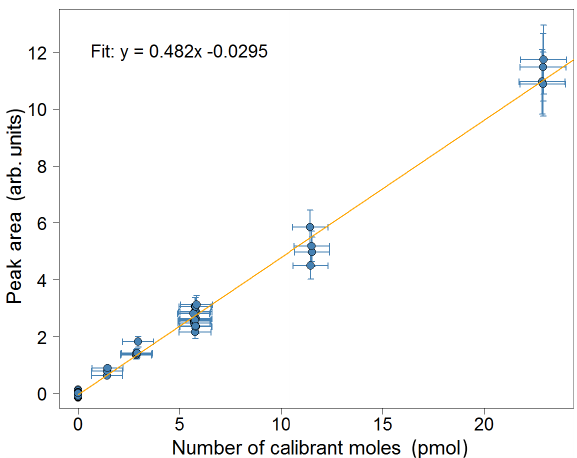
Figure 7. Calibration plot for isoprene for the week of 2– 8 July 2018 from the Wytham Woods field campaign. Error bars in the area correspond to the precision of the measurement ( ± 10 . 4%). Error bars in the calibrant moles are estimated from the uncertain- ties in the secondary standard used and in the volume of gas sam-